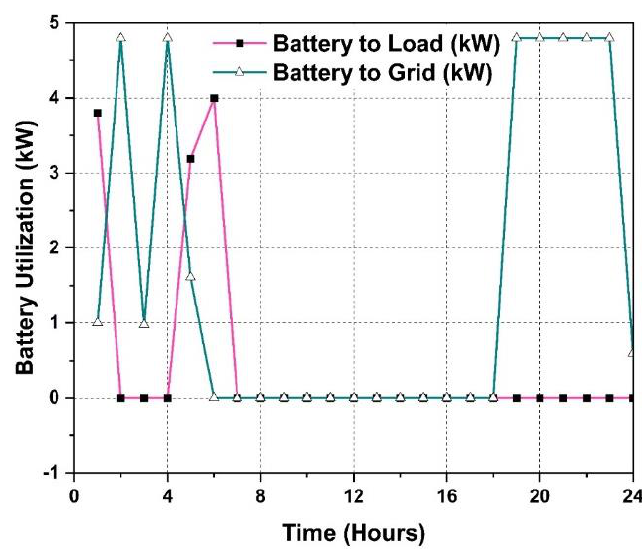
Figure 9. Battery utilization profile (on− grid).